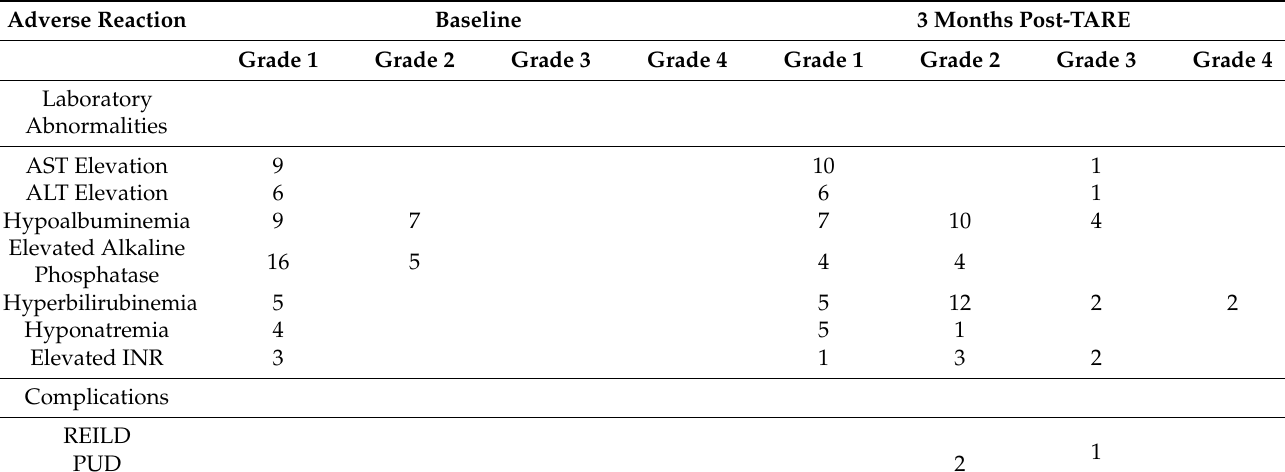
Table 6. Analysis of toxicity and adverse